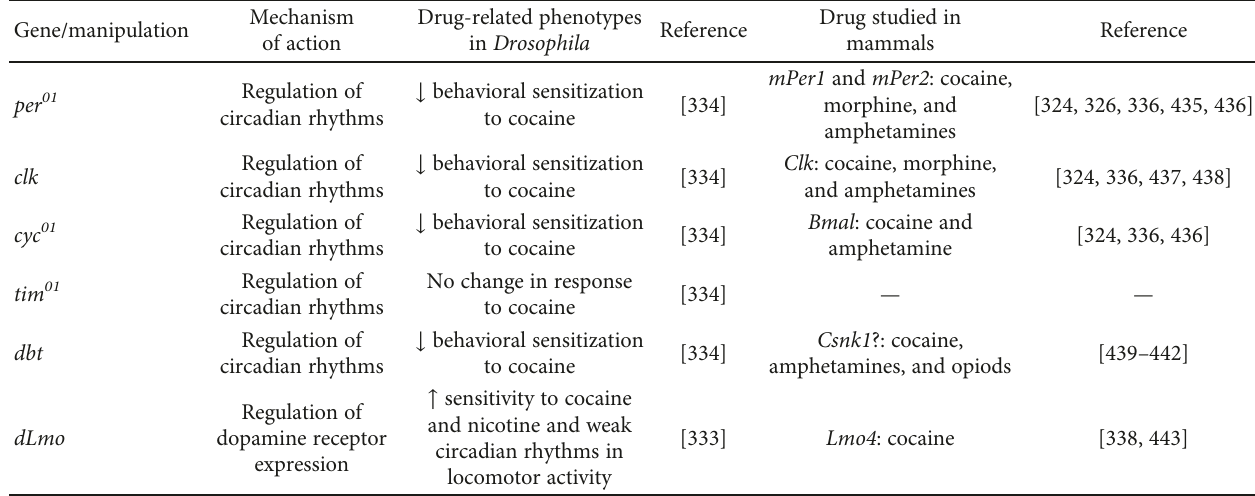
Table 3: Genes mediating circadian and drug interactions in fl ies and